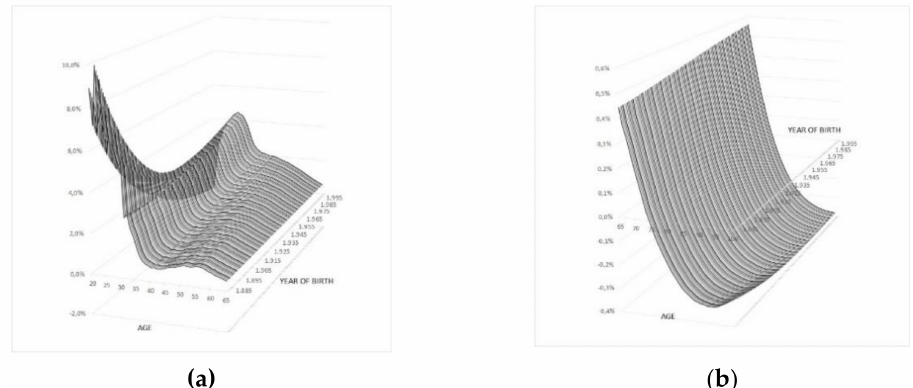
Figure 4. Differential of dependent mortality by gender at each age. Evolution by year of birth: ( a ) Period of activity; ( b ) Period of retirement. Source: Own